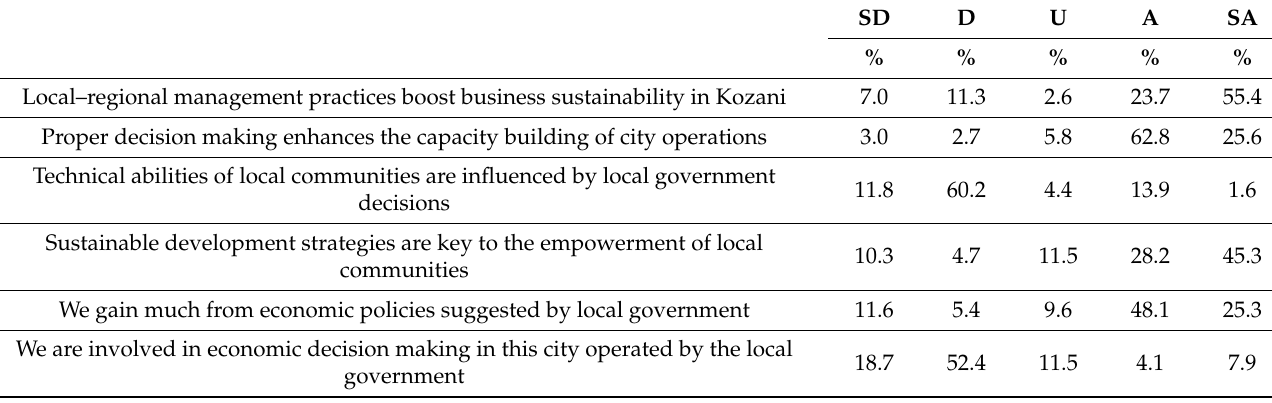
Table 2. Results on the role of local–regional management practices in enhancing the capacity building and technical abilities of local